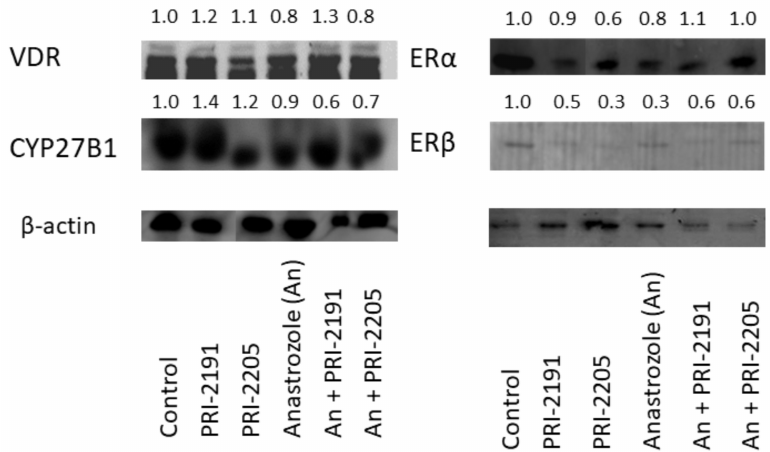
Figure 8. The expression of selected proteins in MCF-7 tumor tissue. NOD/SCID mice were treated with PRI-2191, PRI-2205, and/or anastrozole. Primary antibodies were used in the following concentrations: anti-VDR (sc-1008) 1:400, anti-CYP27B1 (sc-67261) 1:500, and anti-ER α (sc-542) and anti-ER β (sc-8974) 1:500 (all from Santa Cruz Biotechnology Inc., Santa Cruz, CA, USA) and anti- β -actin (Sigma-Aldrich, Pozna´n, Poland) 1:500. ECF Western Blotting Reagent Pack (Amersham, GE Healthcare, Little Chalfont, Buckinghamshire, UK) was used for the analysis. Densitometric analysis was performed using ImageJ 1.43u (Wayne Rasband, National Institutes of Health, USA, https://imagej.nih.gov/ij/, accessed on 8 March